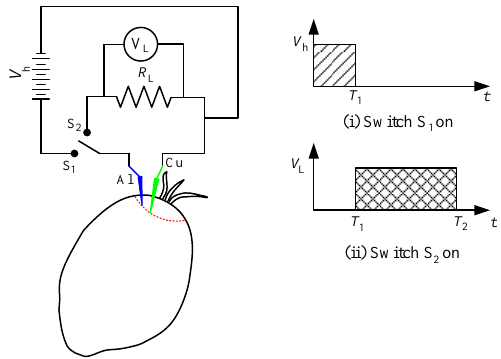
Figure 3. Charging concept with a switching mechanism.